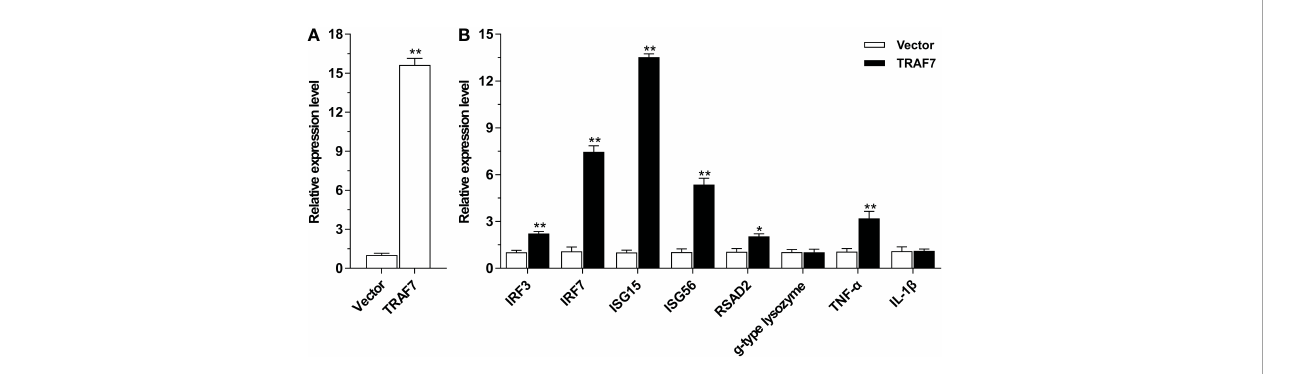
FIGURE 9 Expression patterns of antiviral and in fl ammation-related molecules under overexpression of Lc- TRAF7. (A) The con fi rmation of the overexpression of Lc-TRAF7 . (B) The relative expression patterns of antiviral and in fl ammation-related molecules under Lc-TRAF7 overexpression. The LYCMS cells were transfected with pcDNA3.1-TRAF7 or pcDNA3.1 empty vector (control), respectively. At 48 hpt, the cells were then collected for the extraction of total RNA, follow by reverse transcription into cDNA and qRT-PCR analysis. The mRNA expression levels of large yellow croaker TRAF7 , IRF3 , IRF7 , ISG15 , ISG56, RSAD2 , g-type lysozyme , TNF- a , and IL-1 b were normalized to the expression of L. crocea b -actin , and then recorded as the fold relative to the group transfected with the pcDNA3.1 empty vector. All data are shown as mean of three repeated experiments, with bars representing the SE. * P < 0.05, ** P <